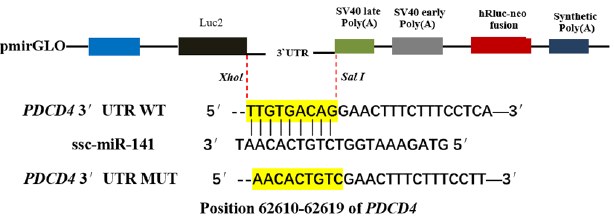
Figure 1. Schematic diagram of pmirGLO-PDCD4-3’UTR recombinant vector.